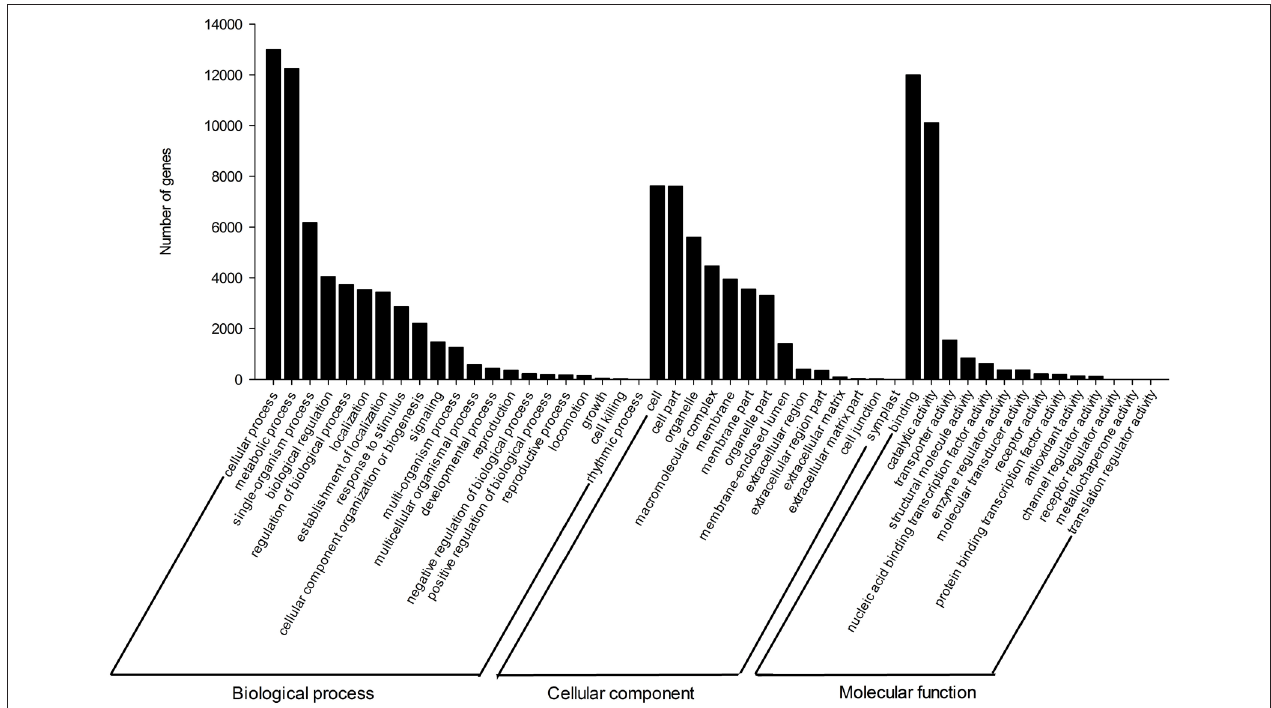
FIGURE 2 | Functional annotation of unigenes based on gene ontology (GO) categorization. Main functional categories in the biological process, cellular component, and molecular functions relevant to plant physiology. Bars represent the numbers of Gnetum parvifolium assignment proteins with BLASTX matches to each GO term. One unigene may be matched to multiple GO